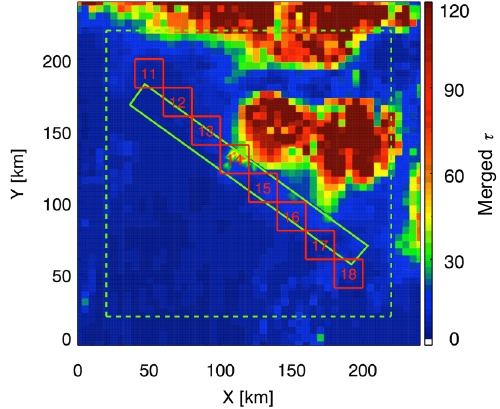
Figure 2. Optical thickness of the large-scale cloud field. The green rectangle marks the embedded MAS swath (Fig. 1); the red squares mark 20km “super-pixels” within the scene. Radiative transfer model output outside the dashed green square is discarded (see Sect.